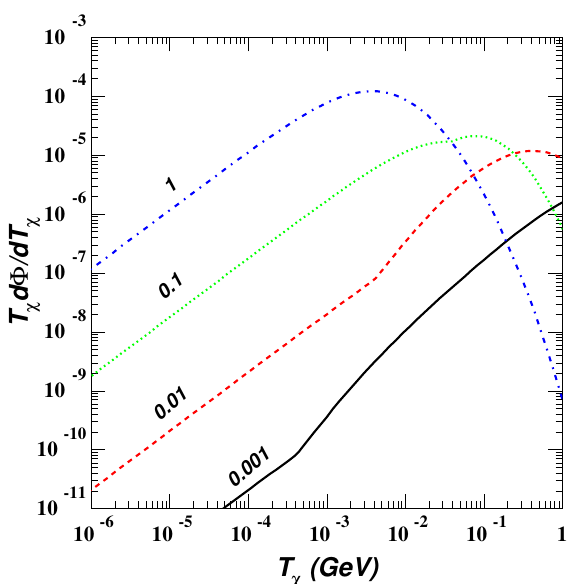
Figure 2 . The expected flux of CRDM with the spin-2 mediator. The curves from left to right corresponds to DM mass m χ = 1 , 0 . 1 , 0 . 01 , 0 . 001 GeV, respectively. The cut-off scale Λ is set at 1 GeV and the couplings c DM and c SM are assumed to be